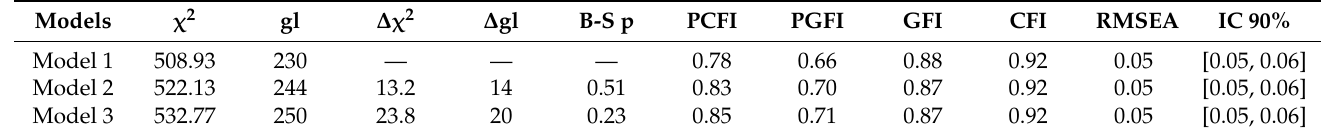
Table 5. Results of the CFA Multi-Group Analysis of the SAI-Rp